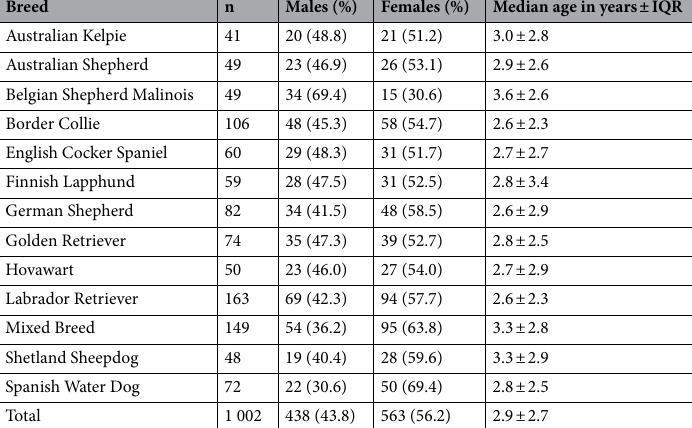
Table 1. Number of dogs within each breed and their sexes and median ages.